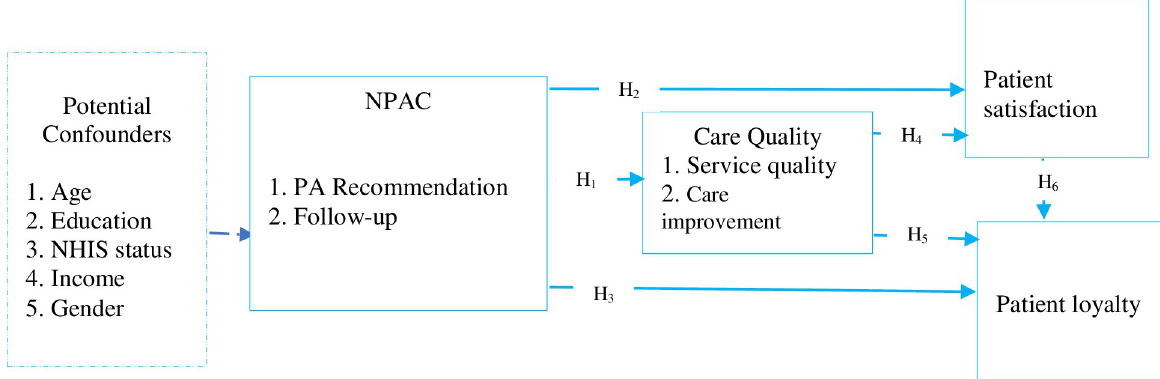
Fig 1. A framework of the relationships between NPAC, care quality, patient satisfaction, and loyalty. Note : NPAC–nurses’ physical activity counselling, PA–physical activity; NHIS–National Health Insurance Scheme; broken arrow from the potential confounders represents confounding; H 1 –the association between NPAC and care quality; H 2 –the association between NPAC and patient satisfaction; H 3 –the association between NPAC and patient loyalty; H 4 –the association between care quality and patient satisfaction; H 5 –the association between care quality and patient loyalty; H 6 –the association between patient satisfaction and loyalty.